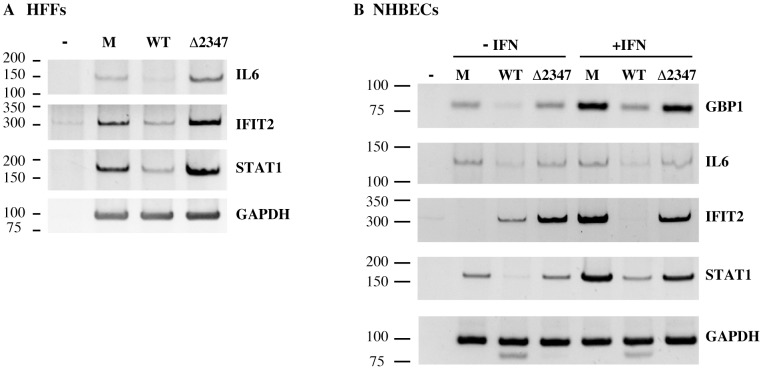
Comparison of the steady state concentrations of IFN-inducible RNAs in wild-type -and E1B 55 kDa null-mutant-infected cells.(A) The concentrations of the primary transcripts of the IFN-inducible genes indicated, and of GADPH mRNA, were compared by RT-PCR as described in Materials and Methods in untreated HFFs infected with 30 p.f.u./cell AdEasy E1 (WT) or AdEasyE1Δ2347 (Δ2347), or mock-infected (M). (B) The primary transcripts and mRNAs indicated were examined in NHBECs infected for 24 hrs with the viruses indicated or mock-infected (M), and untreated or exposed to IFN as indicated. In both panels, the positions of DNA markers (bp) are indicted at the left, and samples marked – above the lanes are the products of reactions that contained Δ2347-infected cell RNA, but no reverse transcriptase.